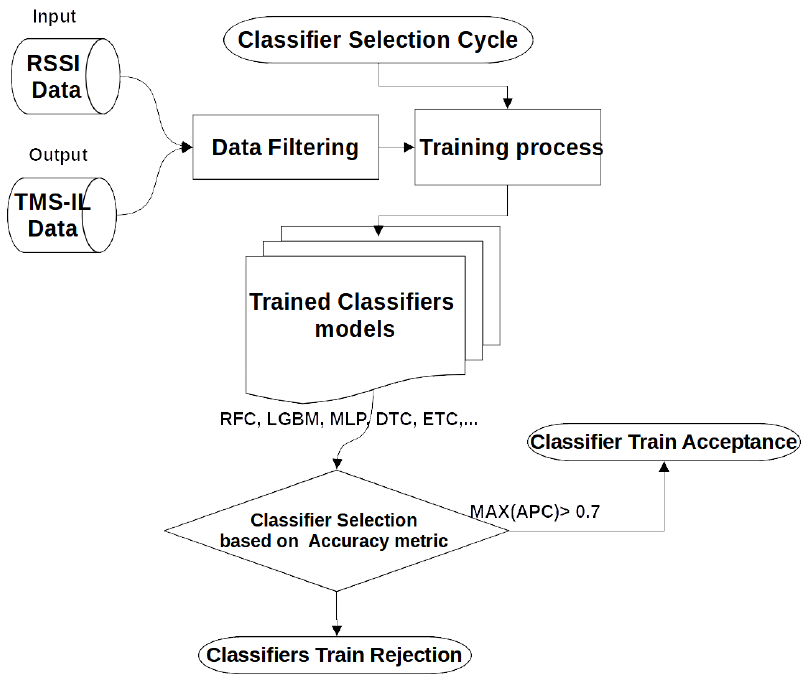
Figure 4. Proposed speed estimation–classification